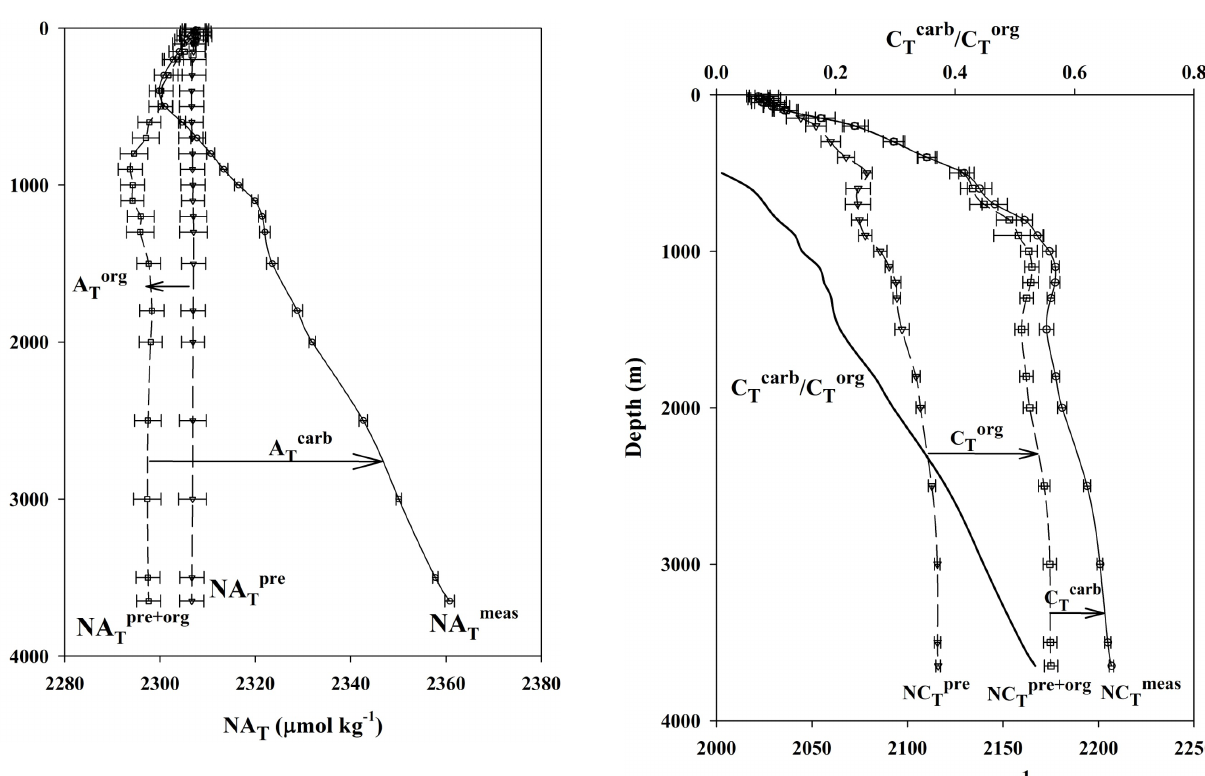
Fig. 9 , open circles), Fig. 9. Depth profiles of measured NA T ( NA meas T pre-formed NA T ( NA pre , open triangles), and preformed plus or- T Fig. 10 + org Fig. 10. Depth profiles of measured NC T ( NC meas , open circles), , open squares) at ganic change contribution to the NA T ( NA pre T T the ESTOC site for the period between 1995 and 2004. The defini- , open triangles), and pre-formed plus or- pre-formed NC T ( NC pre T + org tions and calculations for each component are given in the text. Hor- , open squares) ganic change contribution to the NC T ( NC pre T izontal bars represent the variation of NA meas at a given depth over at the ESTOC site for the period between 1995 and 2004. The def- T + org the 87 cruises and the uncertainties in the NA pre and NA pre initions and calculations of each component are given in the text. T T calculations. at a given The horizontal bars represent the variation of NC meas T and depth over the 87 cruises and the uncertainties in the NC pre T + org NC pre calculations. The ratio between the contributions due T to the dissolution of particulate carbonates and organic matter re- , at ESTOC implying mineralization, together with the C carb / C org T T their relative contribution to the increase of C T in the water column are also